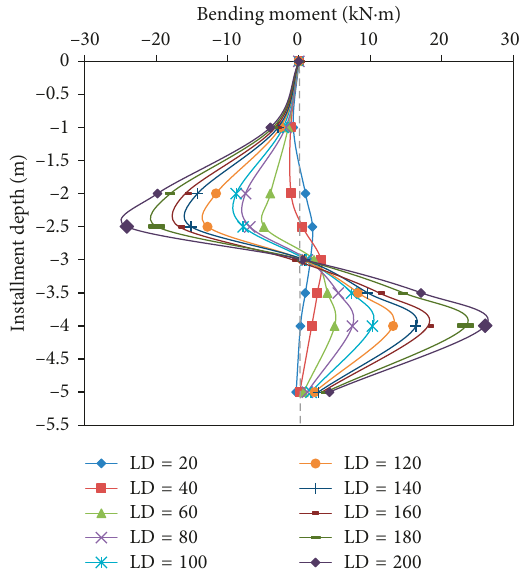
Figure 16: Variation of bending moment with installment depth for Test D No. 2 (loading displacement short for LD).